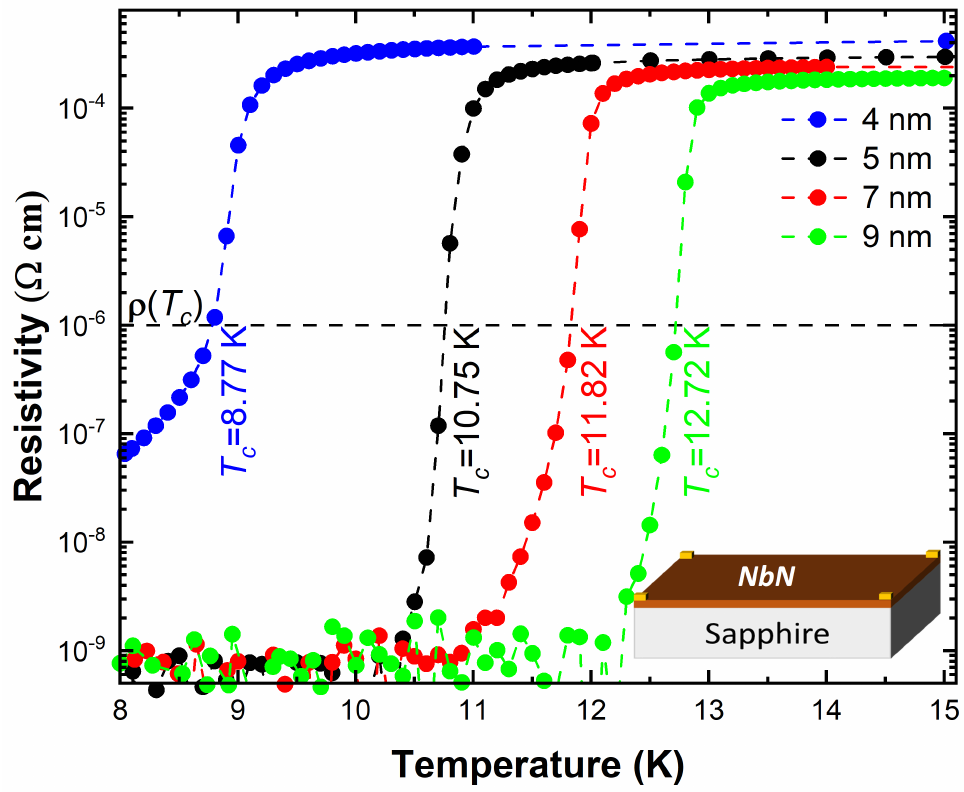
Figure 1. Temperature-dependent resistivity ( ρ ) of 4 nm, 5 nm, 7 nm, and 9 nm NbN on sapphire in Van der Pauw geometry. The critical temperature ( T c ) was defined at ρ = 1 µ Ω cm for generalisation. The critical temperatures were 8.77 K, 10.75 K, 11.82 K, and 12.72 K for 4 nm, 5 nm, 7 nm, and 9 nm NbN thin films,